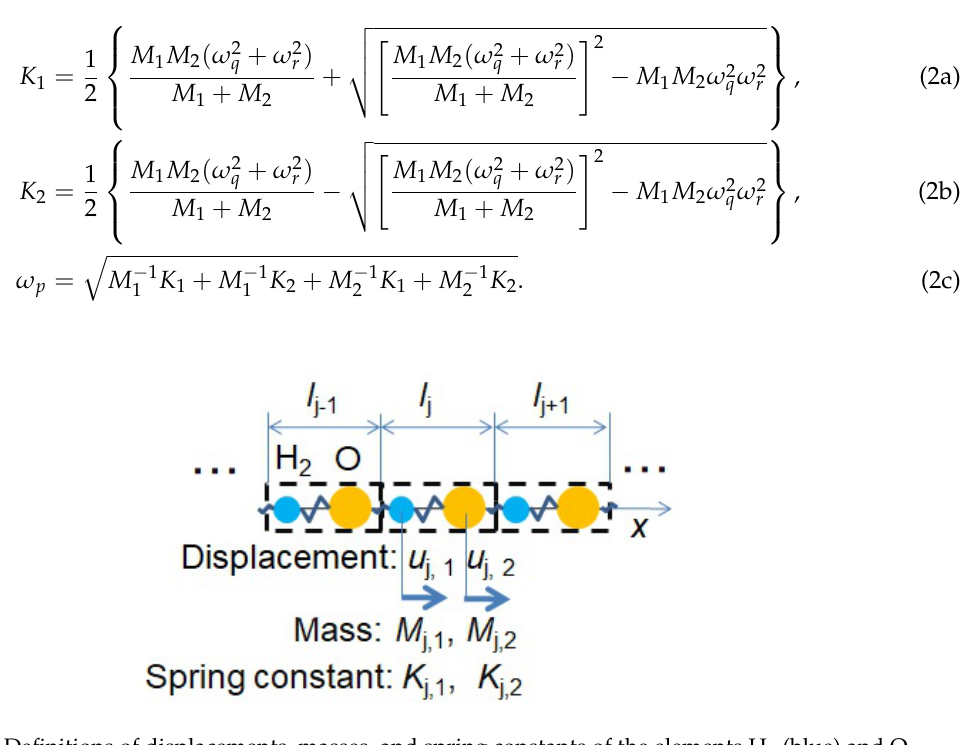
Figure 1. Definitions of displacements, masses, and spring constants of the elements H 2 (blue) and O (yellow) in the one-dimensional phonon model.